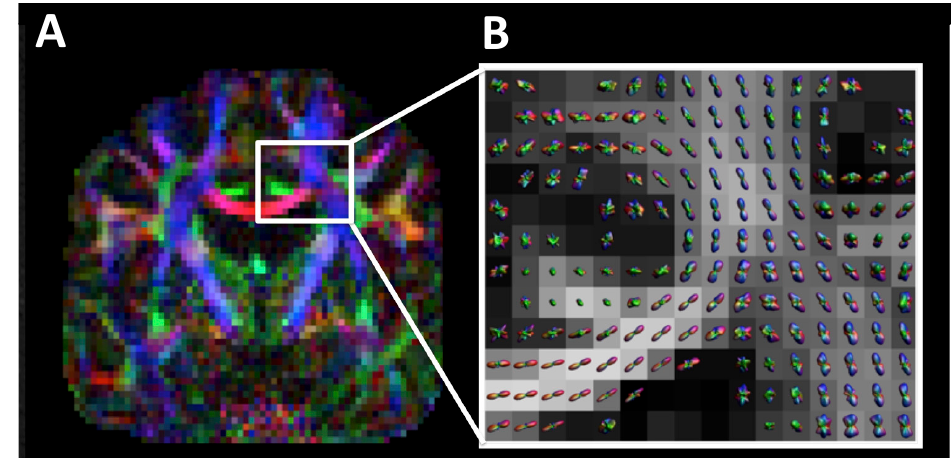
Figure 10. Example of Q-ball imaging (QBI). ( A ) QBI type DTI with color anisotropy map full field of view. ( B ) Zoomed in region from the white rectangle in (A) with probability distributions in each voxel superimposed on a grayscale FA map. QBI acquisition parameters: 112 × 112 matrix; 22.4 × 22.4 cm field-of-view; 70 axial slices of 2 mm thickness; 6 b.0 images; 60 gradient directions at b.2500 s/mm 2 ; SENSE acceleration factor 2; TE/TR.107 ms/10.3 s; and, acquisition time 11 m 20 s.